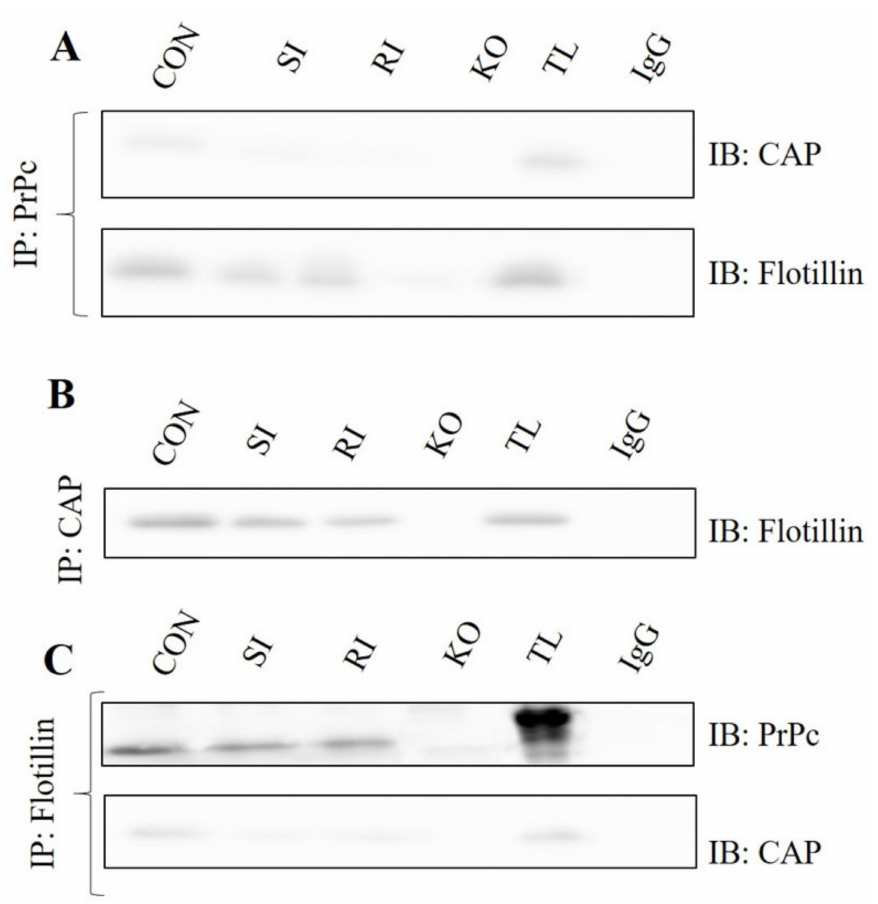
Figure 6. Interaction between the PrPc, flotillin and CAP were analyzed in control, single and repeated TBI mice brains using co-immunoprecipitation and Western blotting techniques. ( A ) Repre- sents PrPc immunoprecipitated and blotted with CAP and flotillin. ( B ) Represents CAP immuno- precipitated and blotted with flotillin. ( C ) Represents flotillin immunoprecipitated and blotted with CAP and PrPc ( n = 3). CON—control; SI—single induction; RI—repeated induction; KO—PrPc null mice